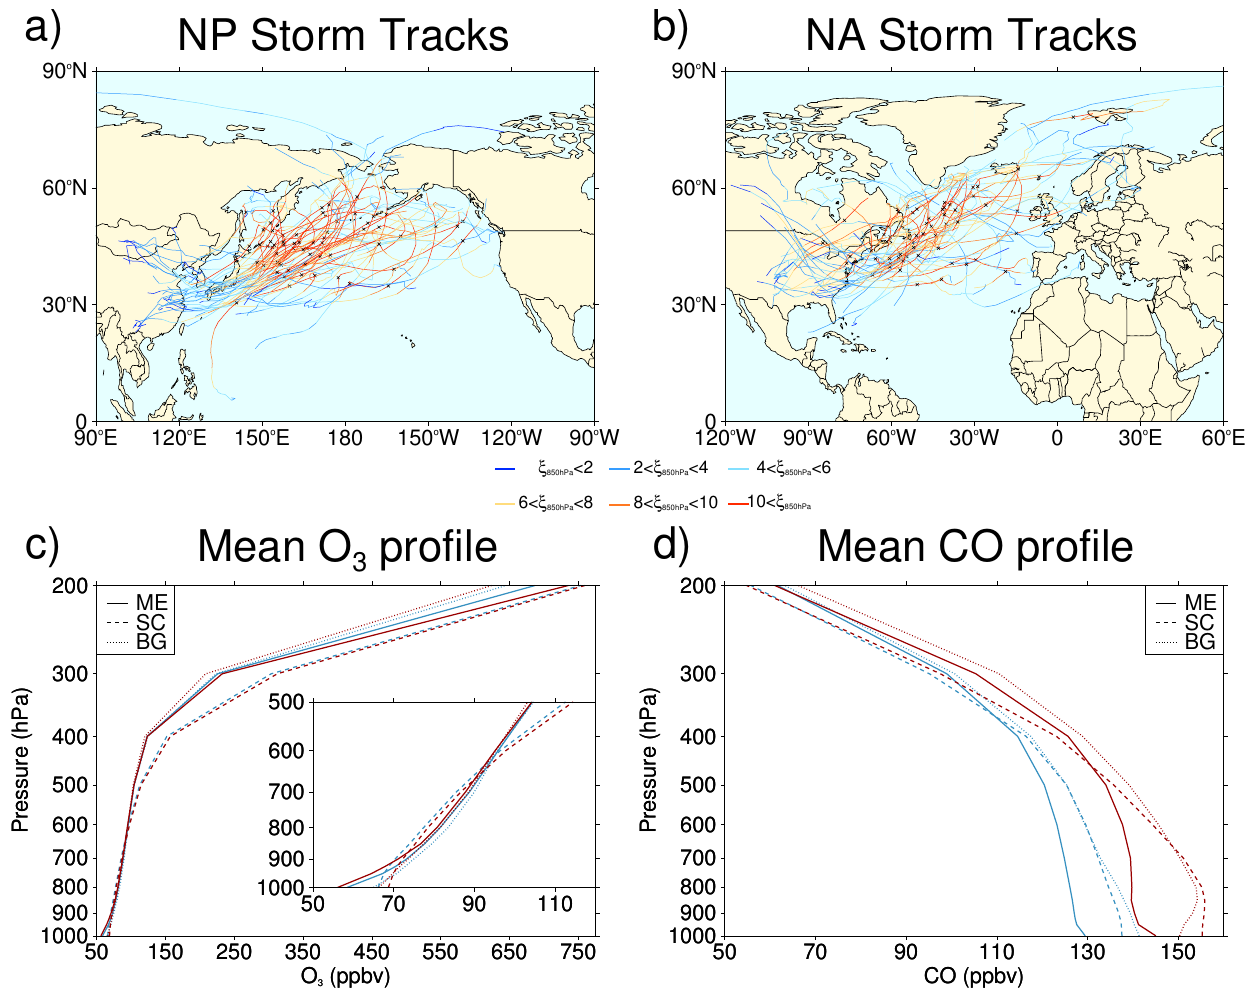
Figure 1. Storm tracks with maximum ζ 850 (10 − 5 s − 1 ) in the 95th percentile for MAM during 2003–2012 for (a) NP and (b) NA regions. The time step where maximum ζ 850 occurred is marked by an x, and the strength of the storm is indicated by the color (increasing strength from blue to red). The vertical profiles for (c) O 3 and (d) CO for NP (red lines) and NA (blue lines) are shown: the MAM 2003–2012 mean MACC O 3 and CO for the NP and NA regions (ME; solid lines), the storm-centered composite aavg-O 3 and aavg-CO (SC; dashed lines), and the background composite aavg-O 3 and aavg-CO (BG; dotted lines) at the time of the storm-centered composite maximum ζ 850 (see Figs. 2 and